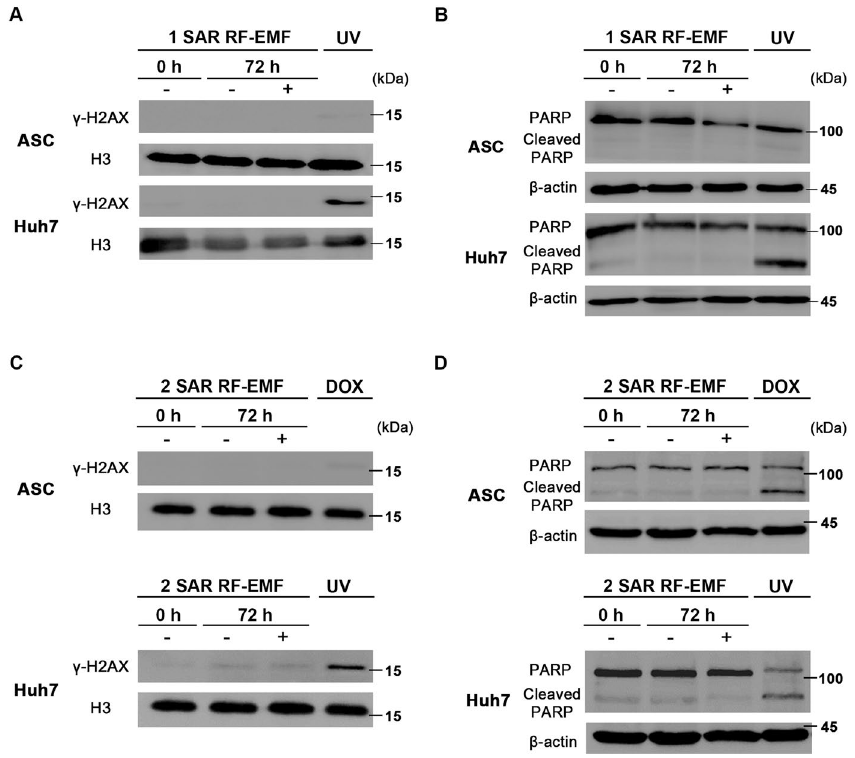
Figure 5. Continuous 1.7 GHz LTE RF-EMF exposure did not induce DNA damage and cellular apoptosis in ASCs and Huh7 cells. ( A–D ) ASCs and Huh7 cells were continuously exposed to 1.7 GHz LTE RF-EMF for 72 h at 1 SAR ( A,B ) or 2 SAR ( C,D ) and collected. Cells were lysed with lysis buffer and histones were extracted, which were separated by 8–15% SDS-polyacrylamide gel electrophoresis (PAGE) for western analyses. Western blots were performed with ( A,C ) anti γ -H2AX and anti-histone H3 antibodies, ( B,D ) anti-PARP and actin antibodies. Cells exposed to UV or treated with 3 μ M doxorubicin (DOX) were used as positive controls for DNA damage and apoptosis. ( A,C ) Histone H3 and ( B,D ) β -actin from the same blot were used as a loading control. More than three independent replicates of all experiments were performed. The original full-length blots/gels were presented in the Supplementary